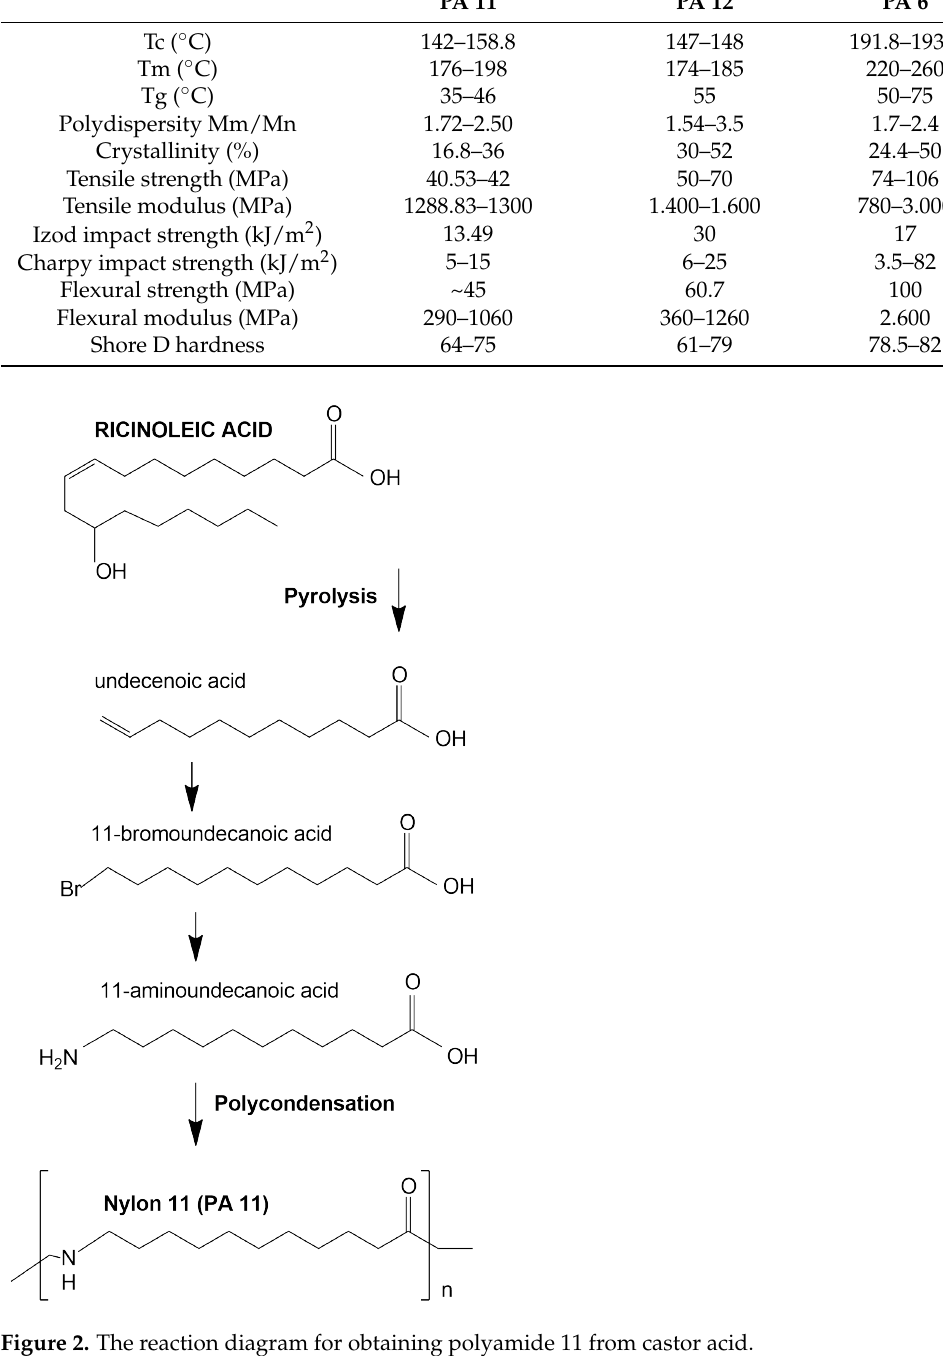
Figure 3. Monomers of polyamides; A—PA 11, B —PA 12, C— PA 6. Polyamide 11 can be processed in several ways. Among the most popular are injection molding and extrusion. In addition, rotational molding is a relatively new form of processing [18]. PA 11 is also successfully used in 3D printing as a powder for selective laser sint ering (SLS) [19,20]. Due to its very good mechanical and chemical properties, it found applications for fabrication of components of both underwater and land‐based pipelines, plastic car parts and housings for electronic equipment. It is also used as a coating material and in medicine [21,22]. As with other polymers of technical importance in structural applications, PA 11 has a long record on preparation of composites thereof containing various types of